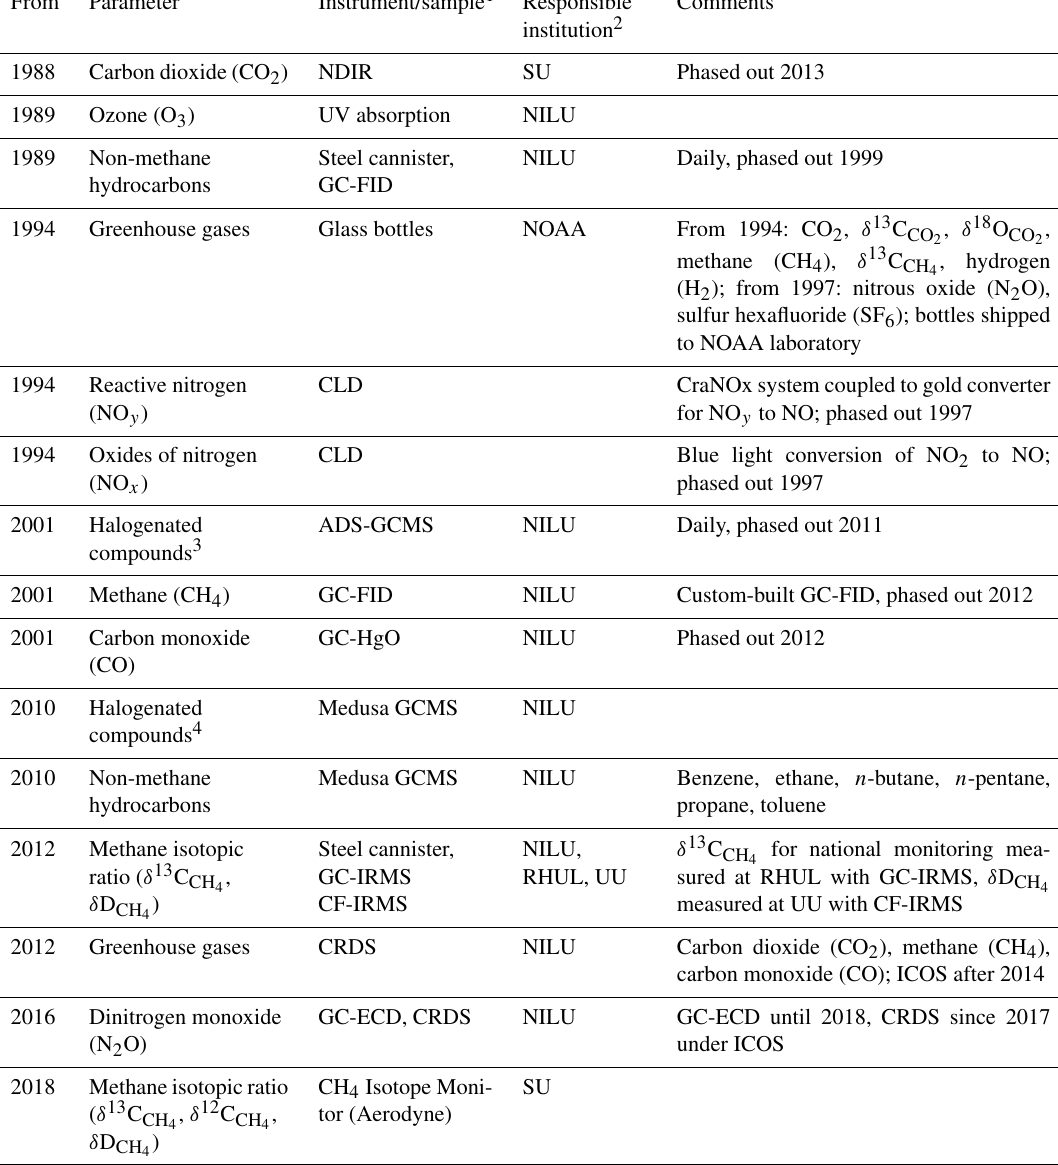
Table 3. Measurements of trace gases at the Zeppelin Observatory, the atmospheric constituent(s) measured, and responsible institutes, listed chronologically by measurement starting year. See table footnotes for full lists of